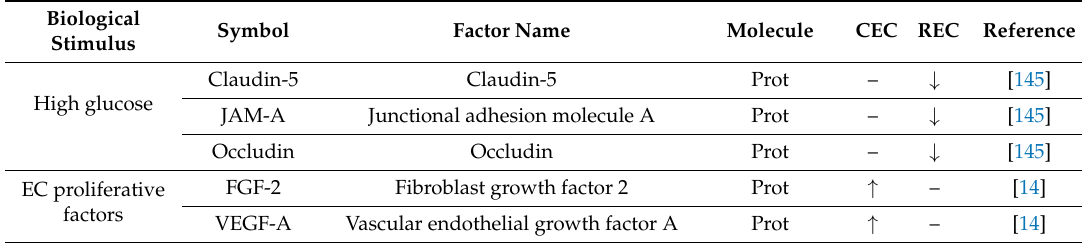
Table 3. Summary of angiogenesis-related factors regulated in REC and CEC in response to non-hypoxia